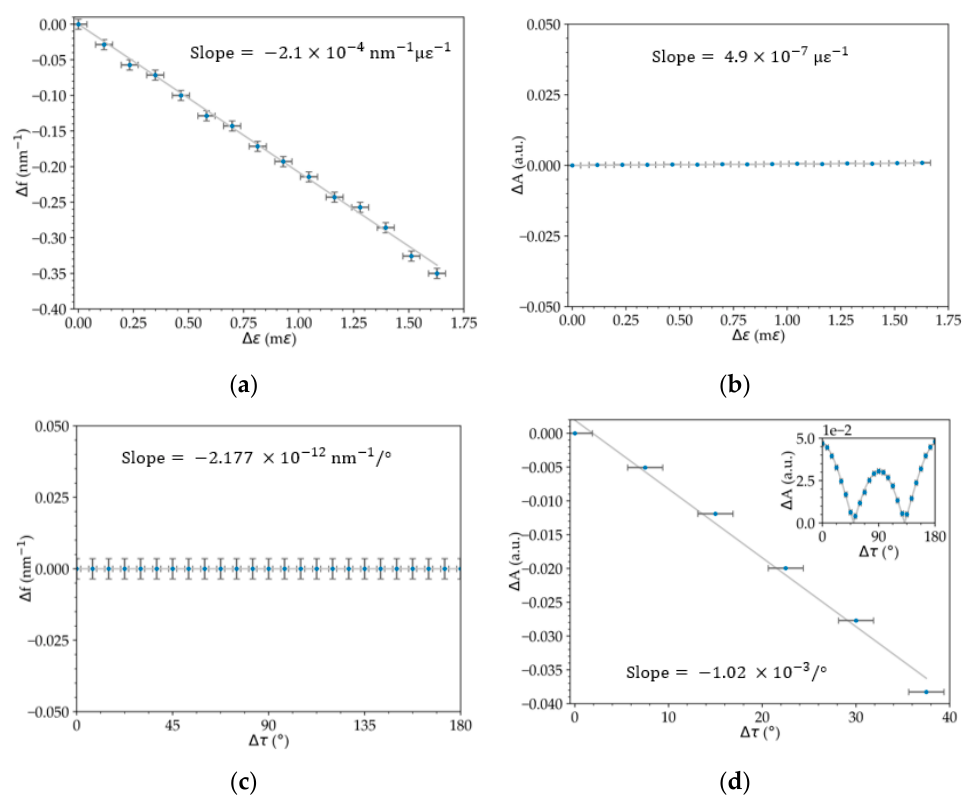
Figure 4. Frequency shift and its amplitude as a function of ( a , b ) strain and ( c , d ) torsion and wavelength shift of a spectrum extreme. Table 1. Linear sensibility of Figures 4 and 5. Figure Sensitivity Figure Sensitivity Strain Torsion Spatial Frequency Shift ( Δ f ) Spatial Frequency Shift ( Δ f ) Figure 4c Figure 4a ( − 2.1 ± 0.3) × 10 − 4 nm − 1 με − 1 ( − 2.177 ± 0.002) × 10 − 12 nm − 1 /° Amplitude ( Δ f ) Amplitude ( Δ A ) Figure 4d Figure 4b (4.9 ± 0.3) × 10 − 7 με − 1 (1.02 ± 0.06) × 10 − 3 /° Spectrum extreme Shift Spectrum extreme Shift Figure 5b Figure 5a (2.09 ± 0.06) pm/° (0.576 ± 0.009) pm ‧ με − 1